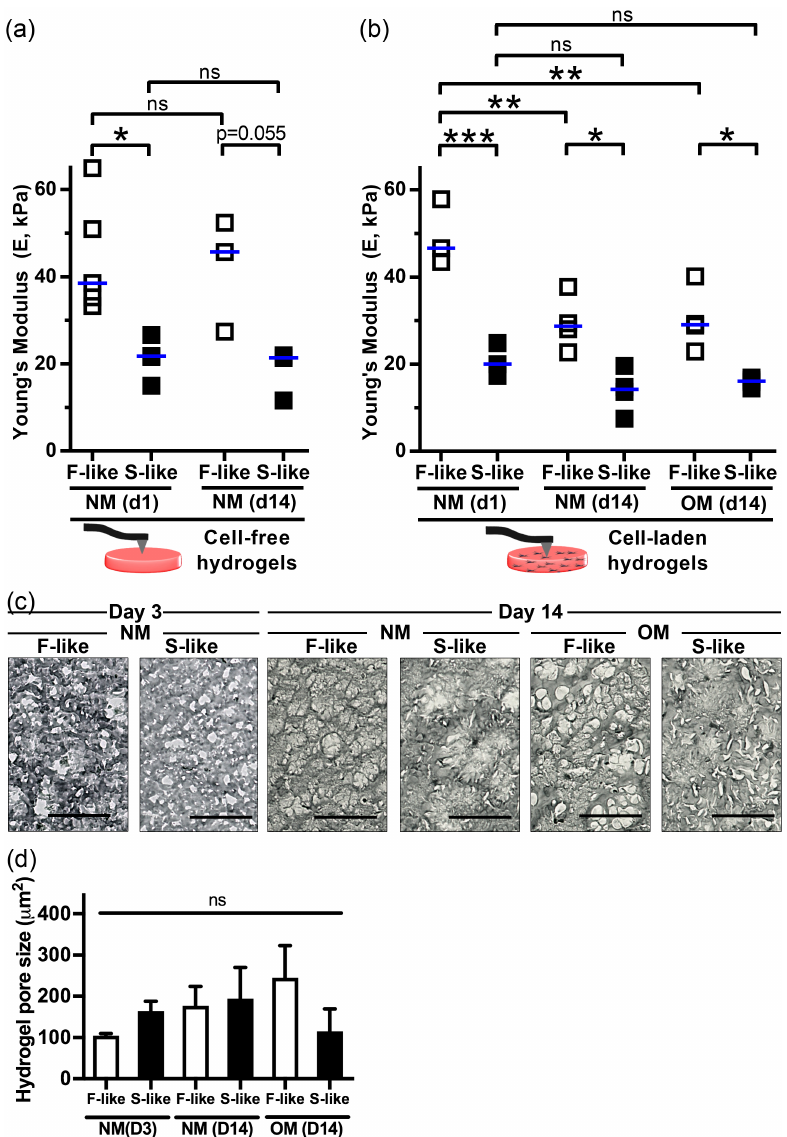
Figure 4. Encapsulation and culture of VICs within fibrosa-like (F-like) but not spongiosa-like (S-like) hydrogels affected hydrogel mechanics: ( a ) The median Young’s modulus of cell-free 3D-bioprinted F-like (5% GelMA/1% HAMA/90 s crosslinking) and S-like (5% GelMA/1% HAMA/30 s crosslinking) hydrogels did not change over 14 days of culture in NM; ( b ) The median Young’s modulus of VIC-laden F-like hydrogels (and not S-like hydrogels) decreased significantly over time in culture (14 days), regardless of NM or OM treatment conditions. Median shown; n = 3–5 samples per condition (9 measurements per sample); ( c , d ) Representative images and quantification of bright-field microscopy demonstrated that after 3 and 14 days in culture (NM and/or OM), pore sizes of F-like and S-like hydrogels were not significantly different. Mean + SEM; * p < 0.05, ** p < 0.01; *** p < 0.001; n = 3 samples per condition; scale bar = 100 µ